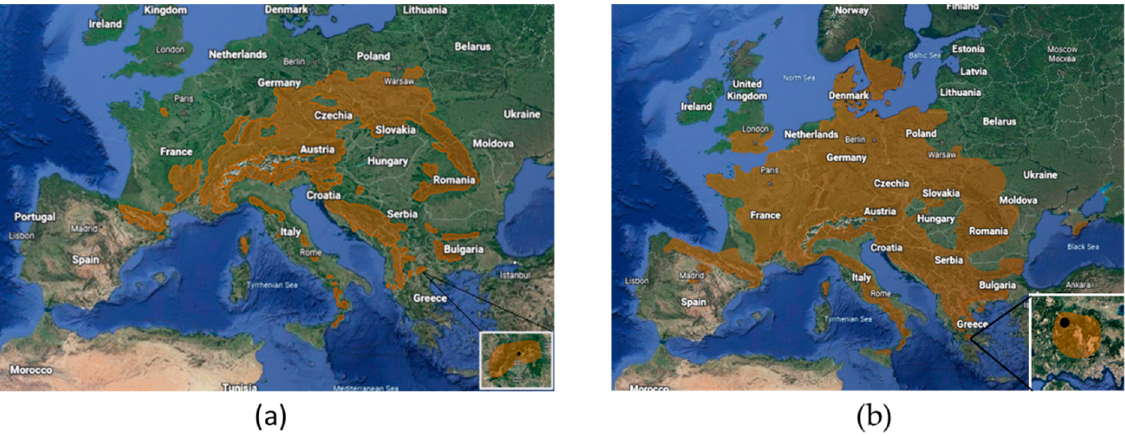
Figure 1. Distribution maps of ( a ) Abies alba and ( b ) Fagus sylvatica . Black circles in the inset of the maps indicate selected Greek populations.